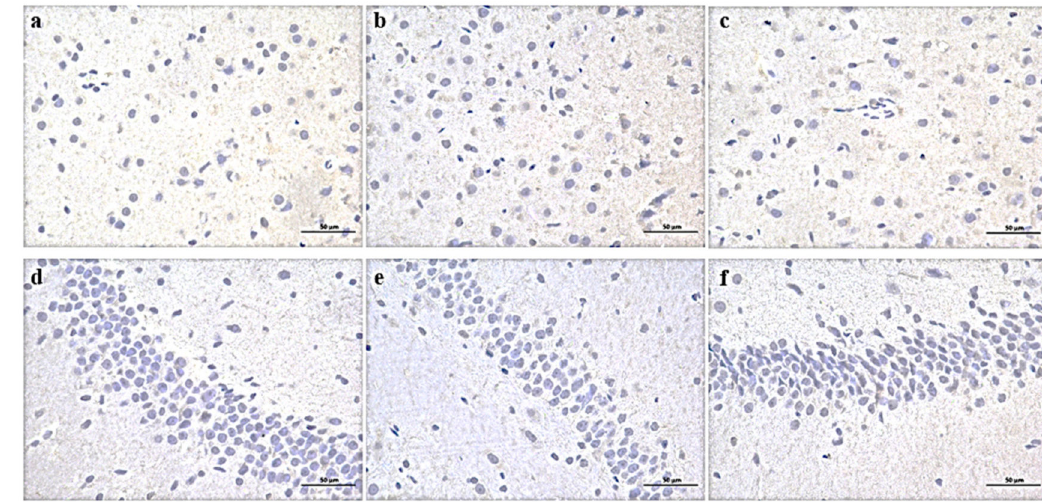
Figure 7. Expression of IDO in prefrontal cortex ( a – c ) and hippocampus ( d – f ) of three groups of rats. ( a , d ) CON group, ( b , e ) GH group, ( c , f ) GL group. DAB ×